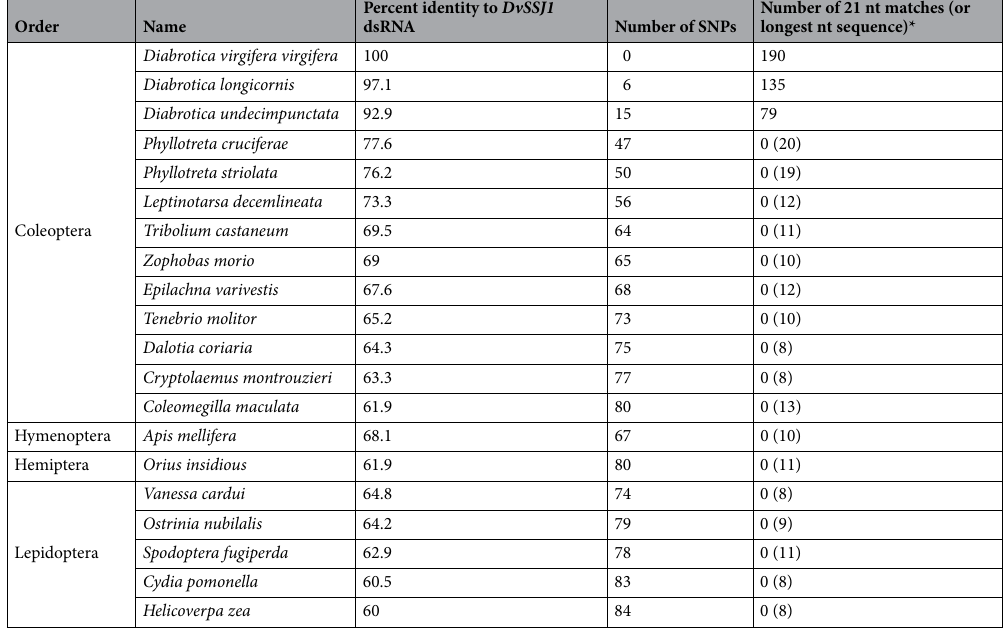
Table 1. Sequence comparison of DvSSJ1 homologous. The sequences of twenty species, representing four families within the order Coleoptera , four families within the order Lepidoptera , and one family each from the order Hymenoptera and Hemiptera were compared to the 210 bp sequence from the WCR SSJ gene to determine the percent similarity, number of single nucleotide polymorphisms (SNPs), and the number of 21nt matches. *Longest nucleotide sequence showing 100% match to DvSSJ1 210 sequence.